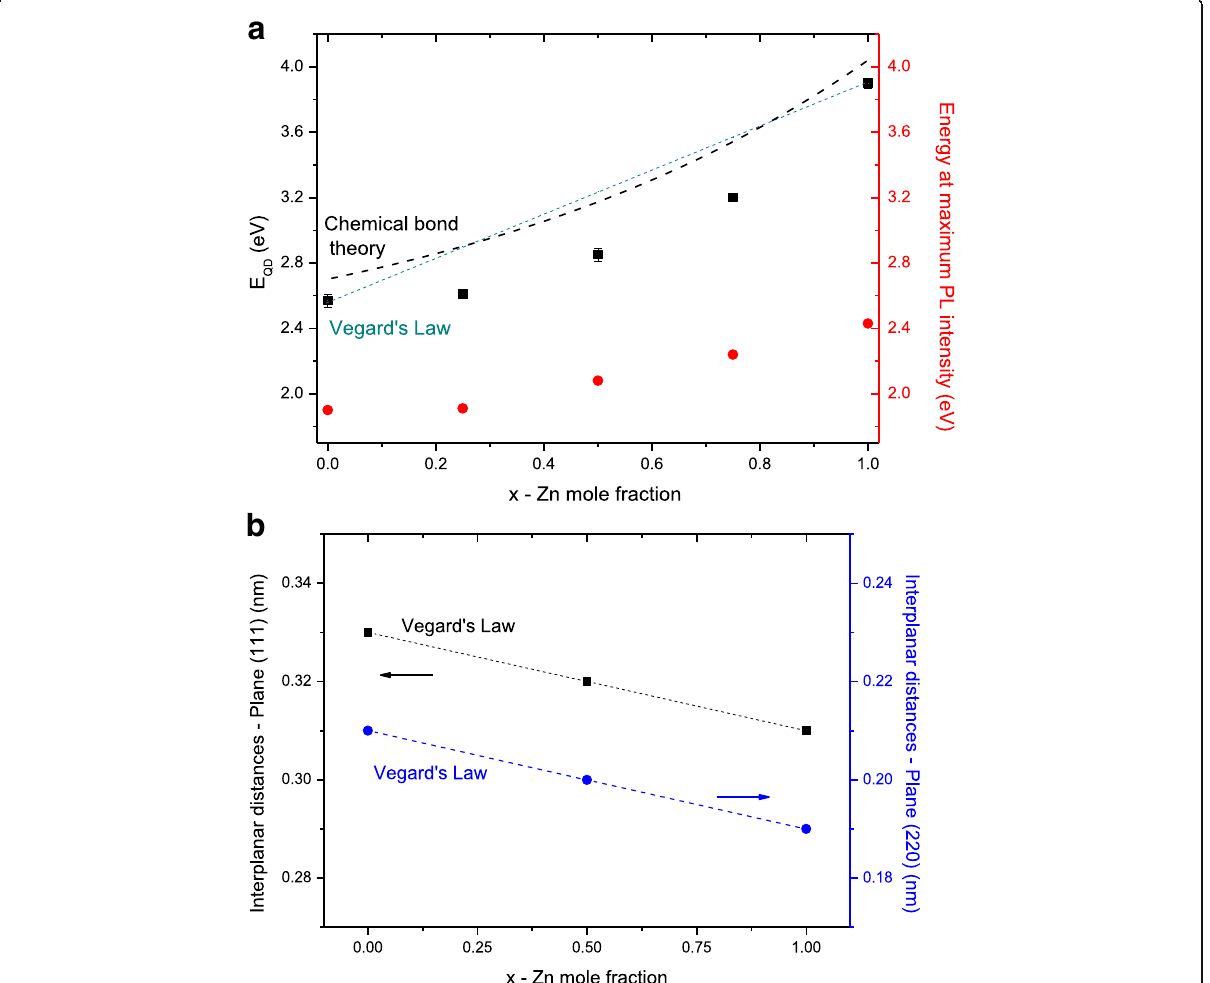
Fig. 5 Empirical and semi-empirical models of semiconductor nanoalloys. a Non-linear relationship of E QD ( squares ) and PL wavelength ( circles ) as a function of the molar content of Zn 2+ . Dotted line indicates Vegard ’ s law (calculated) and dashed line , the expected values based on Chemical Bond Theory (from reference [45]). b Linear relationship of lattice parameters as a function of the concentration of Zn 2+ in the material (data from ED